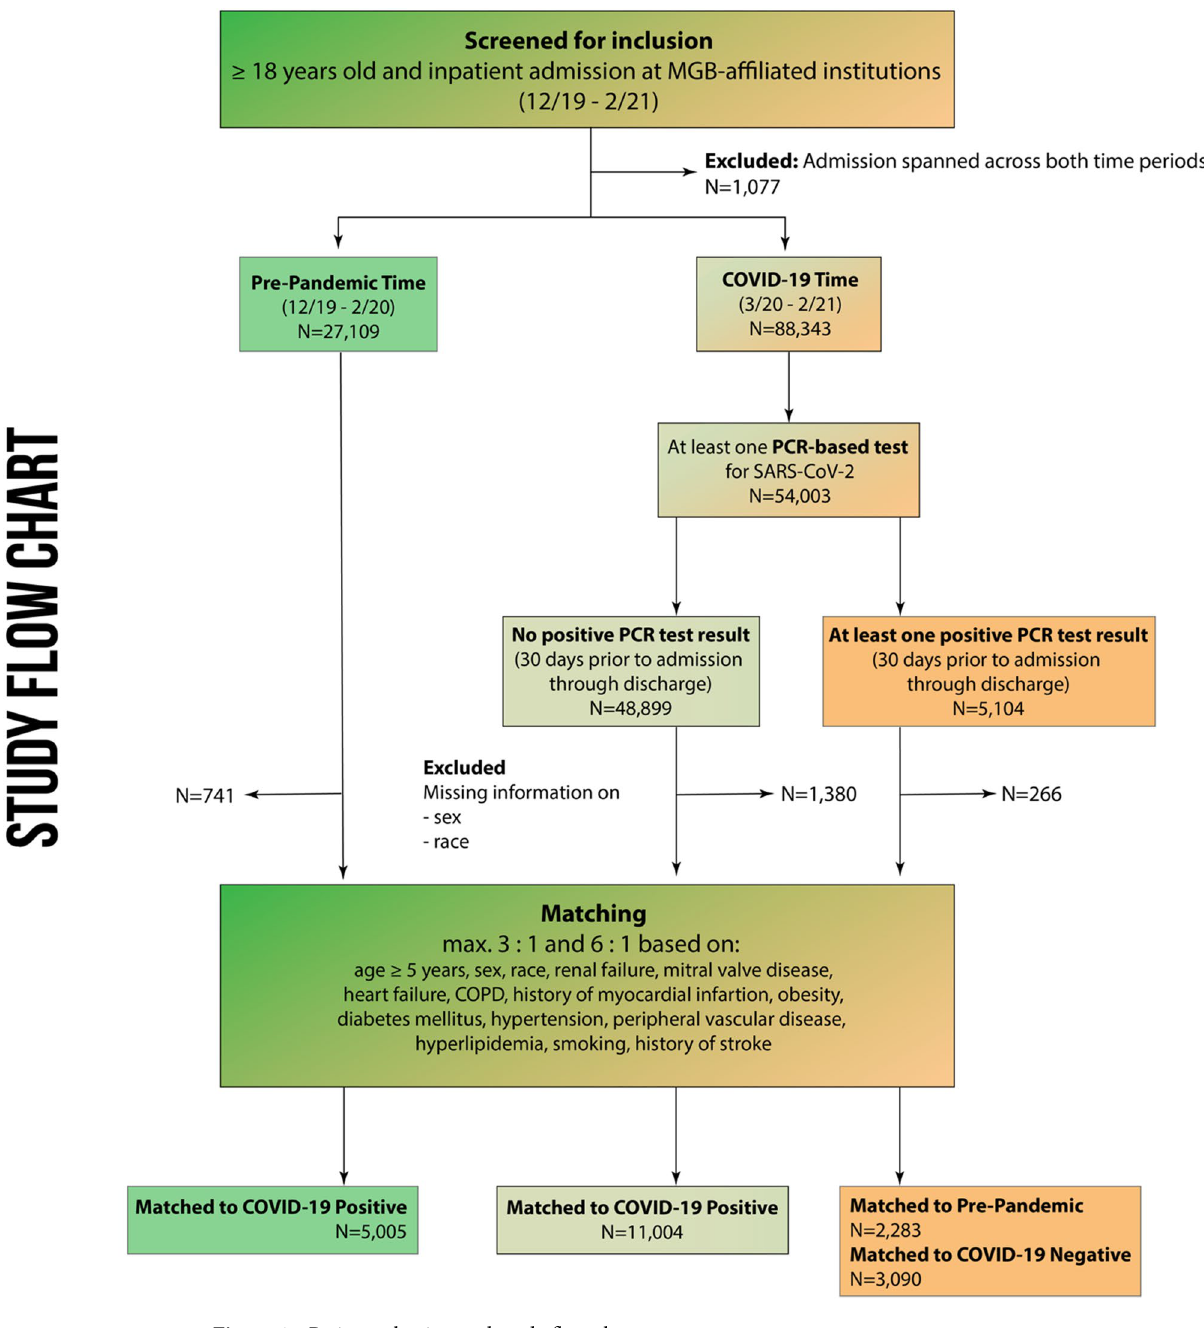
Figure 1. Patient selection and study flow